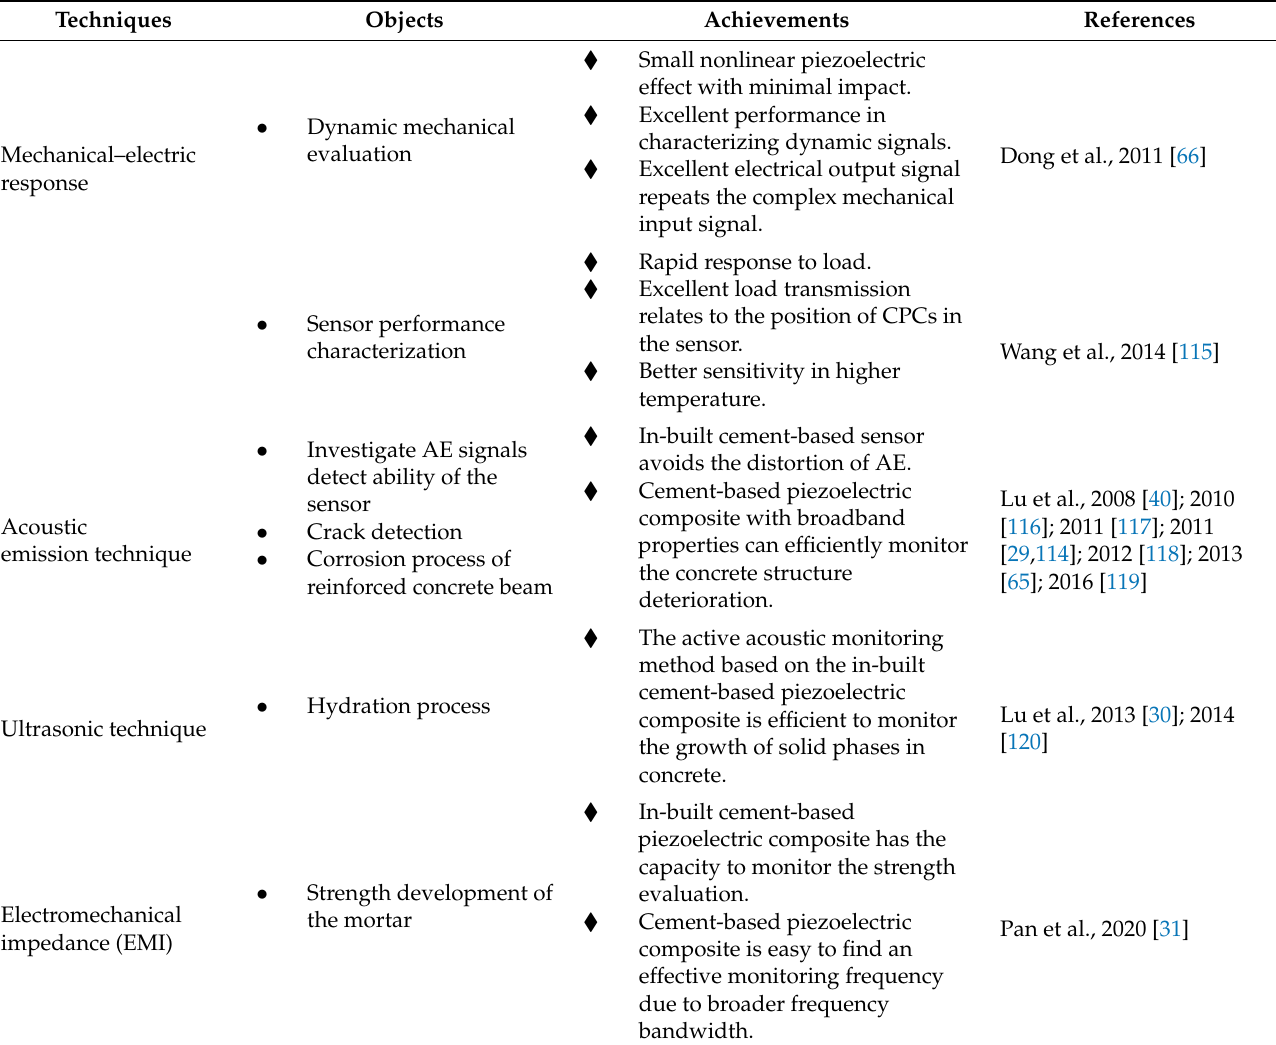
Table 7. Application of cement-based piezoelectric ceramic